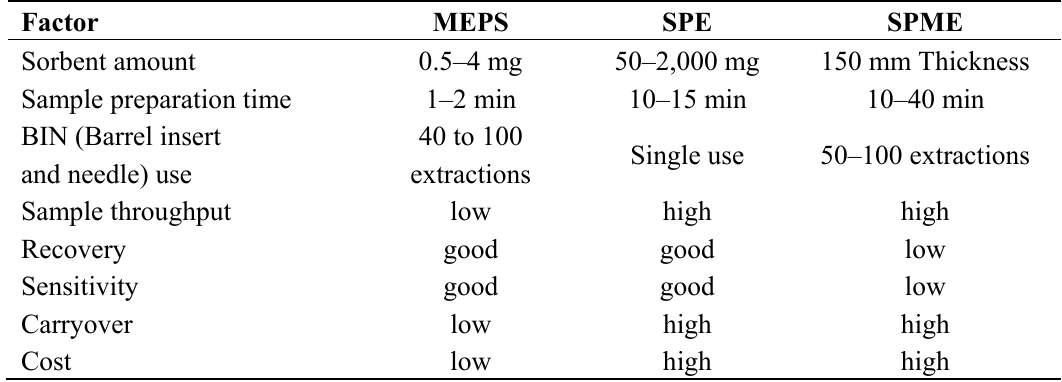
Table 1. A comparison of some characteristics of target sample preparation techniques with solid phase extraction procedures. Reviewed in